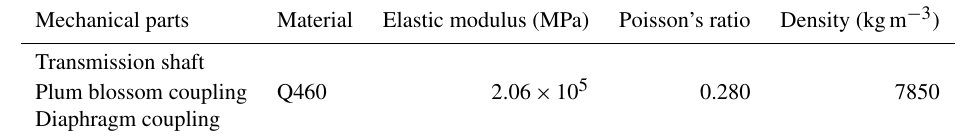
Table 2. Material parameter table of the mechanical parts of the transmission system.